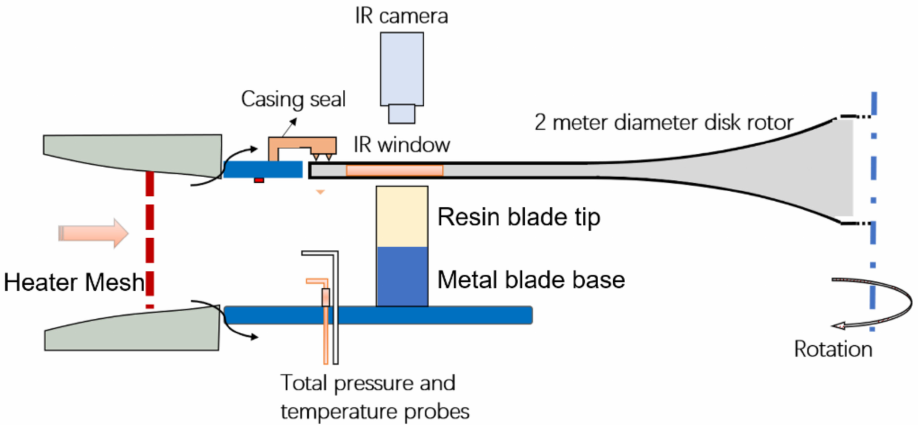
Figure 13. Schematic diagram of test section. Table 2. Flow Conditions of experimental measurements and CFD results. Table 2. Flow Conditions of experimental measurements and CFD